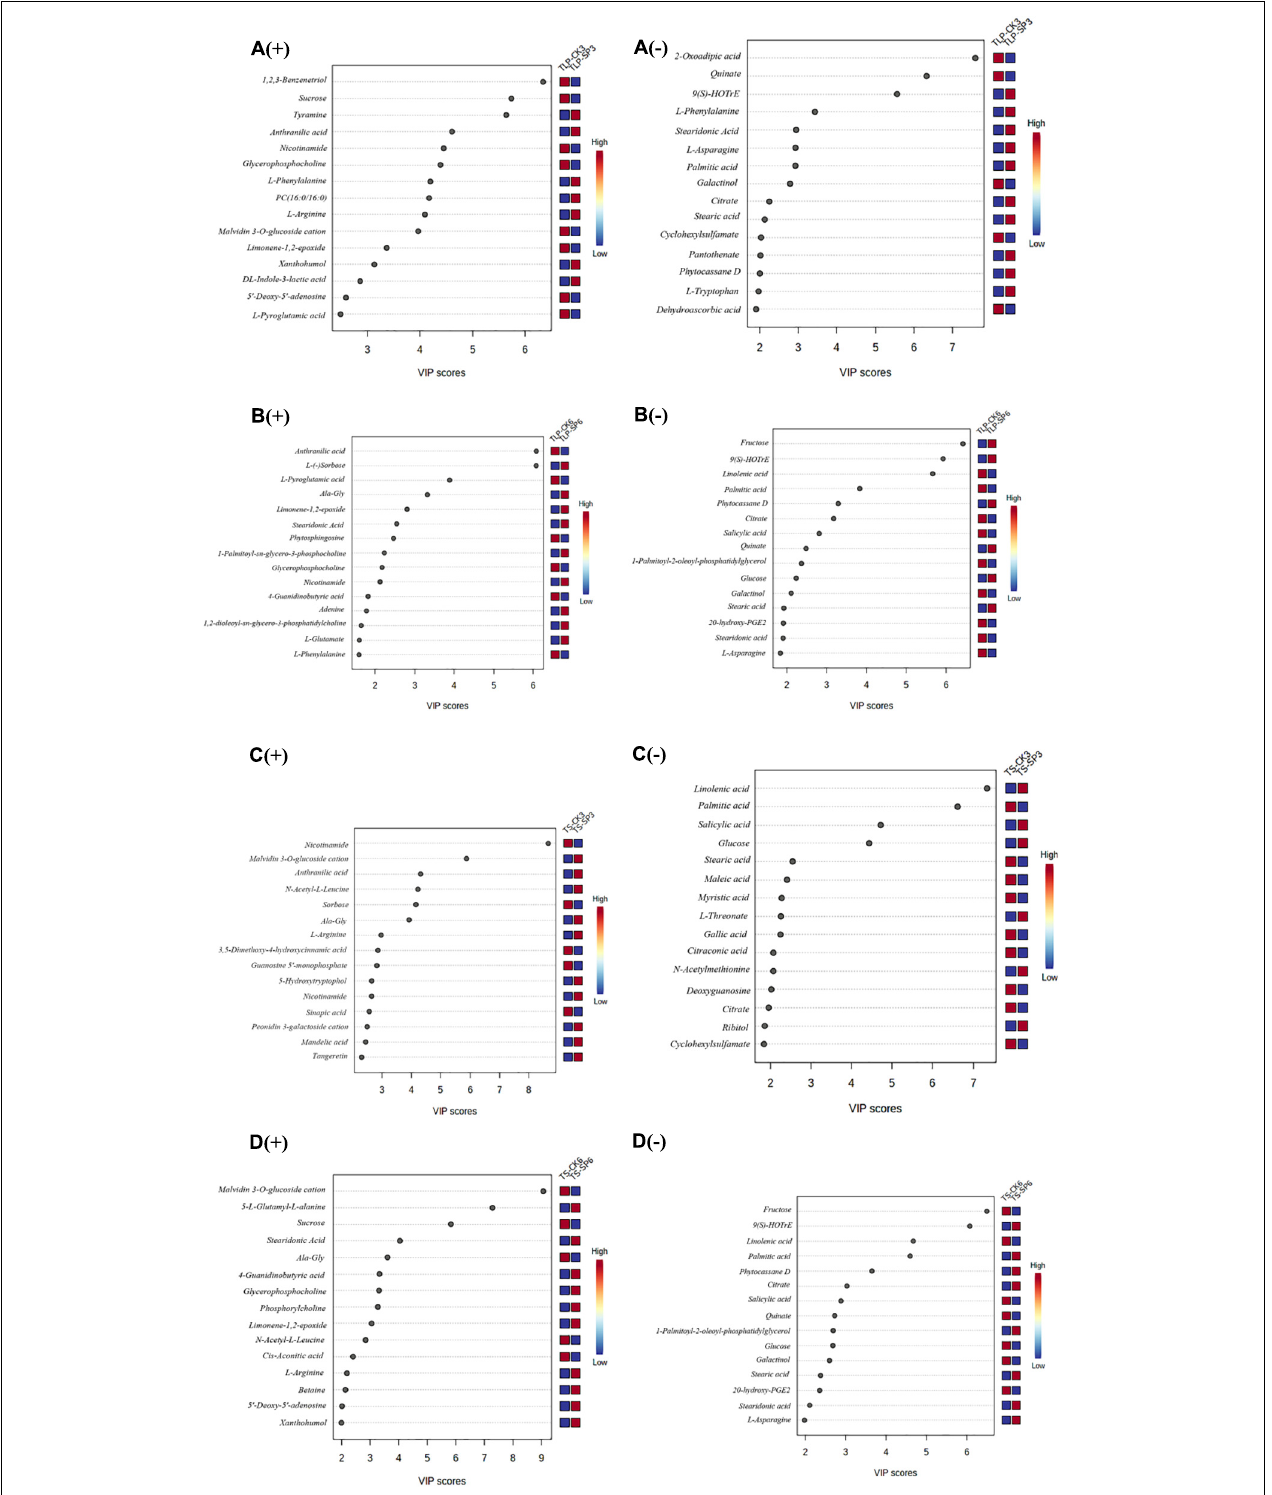
FIGURE 3 | Variable importance in projection (VIP) scores of the top 15 metabolites in grains of the two rice cultivars in different growth stage. Results were from the partial least squares-discriminant analysis (PLS-DA). (A) Rice samples of DN3 at the TLP, (B) rice samples of DN6 at the TLP, (C) rice samples of DN3 at the TS, (D) rice samples of DN6 at the TS; (+) and (–) represent positive and negative ion; TLP and TS represent three leaf period and tillering stage. The higher the VIP scores, the larger the contributions. The relative contents of metabolites were displayed by the color boxes, with red indicating high and green indicating low contents.